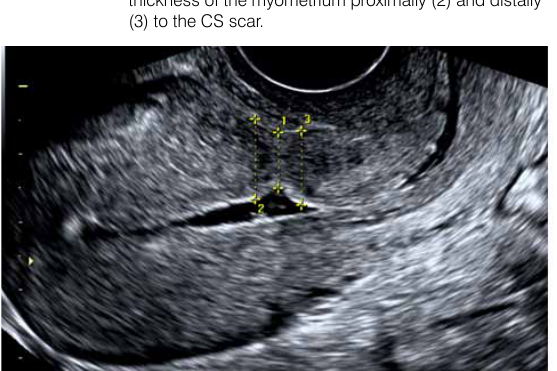
Figure 3. Sagittal plane of the uterus obtained transvaginally 6 weeks after CS. The thickness of the CS scar (1), the thickness of the myometrium proximally (2) and distally (3) to the CS